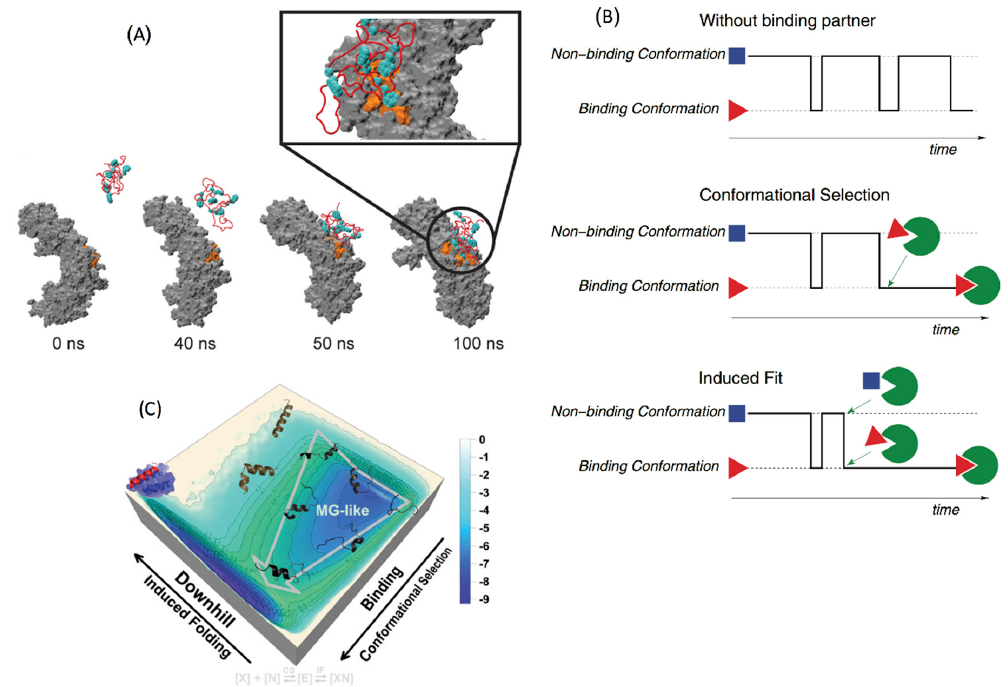
Figure 3. ( A ) Formation of a fast binding fuzzy complex between nucleoporin (red cartoon) and importin β (grey surface), simulated using an all-atom molecular dynamics ( MD) simulation; the binding sites on importin β and nucleoporin are colored in orange and cyan respectively; reproduced with permission from [101] (https://doi.org/10.1016/j.cell.2015.09.047) under the terms of the Creative